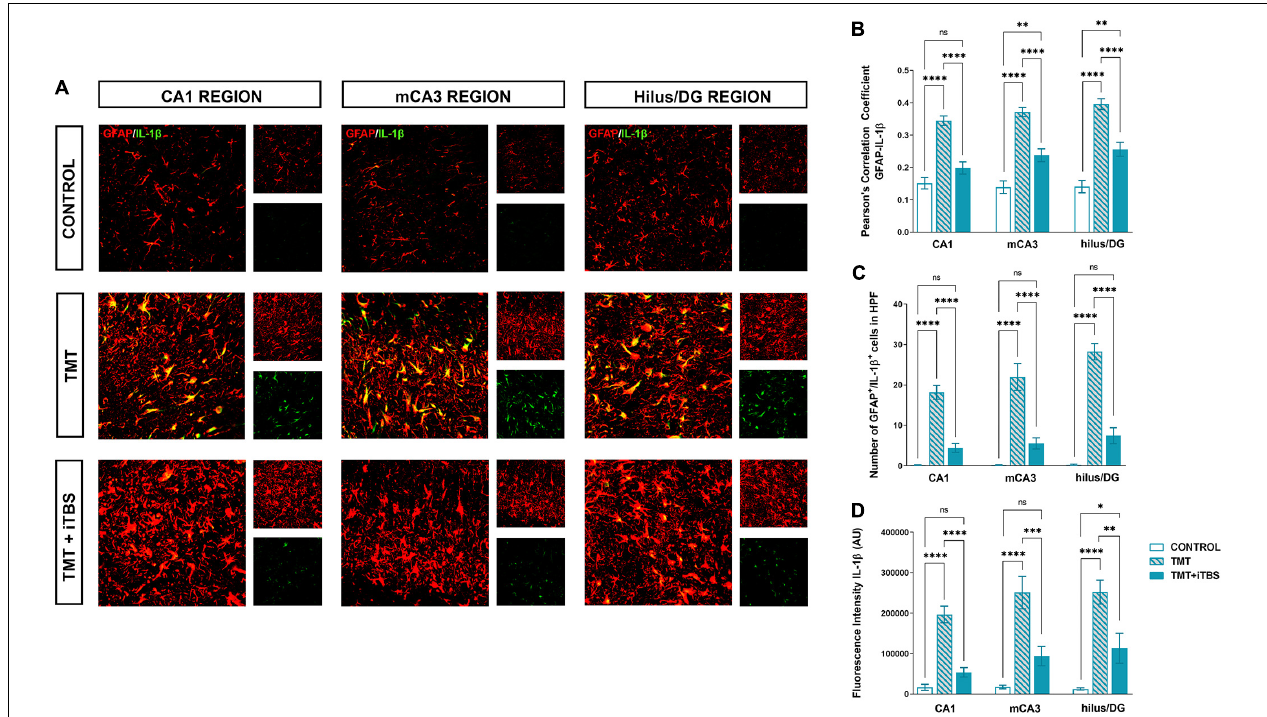
FIGURE 4 | Effect of iTBS treatment on TMT-induced astrocytic inflammation. (A) Double immunofluorescence staining directed to GFAP ( red ) and IL-1 β ( green ) of coronal hippocampal sections captured in the same region levels. Scale bar = 50 µ m. Integration of immunofluorescence intensity and quantitative analyses showing (B) Pearson’s correlation coefficient (PCC), (C) number of GFAP + /IL-1 β + cells in high power field (HPF), and (D) fluorescence intensity of IL-1 β in arbitrary units (AU). Bars represent the mean value ± SEM of specific parameters calculated from acquired images (10–16/animal). Results of post hoc Tukey’s test and significance shown inside graphs: ∗ p < 0.05, ∗∗ p < 0.01, ∗∗∗ p < 0.001, ∗∗∗∗ p < 0.0001, ns, no